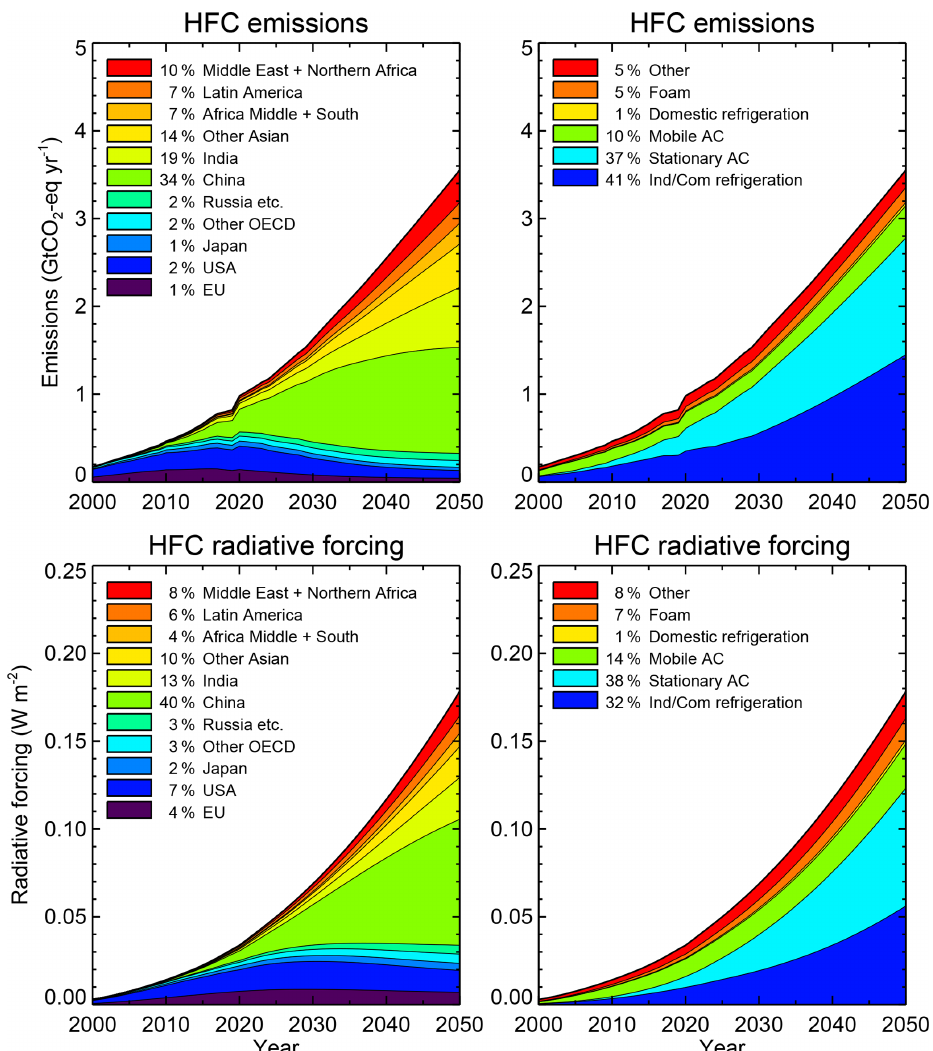
Figure 6. Global total HFC emissions (GtCO 2 eq . yr − 1 ; top panels) and radiative forcing (bottom panels) from the upper range of the current policy Kigali-independent (K-I) scenario. Shown are the contributions from the different regions (left) and different sectors (right). The percentages refer to the relative contributions of the CO 2 eq . emissions and radiative forcing in the upper range in 2050. Industrial and commercial refrigeration (ICR) includes transport refrigeration. For developed countries, the consumption and emissions of each subsector is projected individually, starting from the UNFCCC (2021) data. No subsector information is available for most developing countries; therefore, the ICR is considered as one combined-use